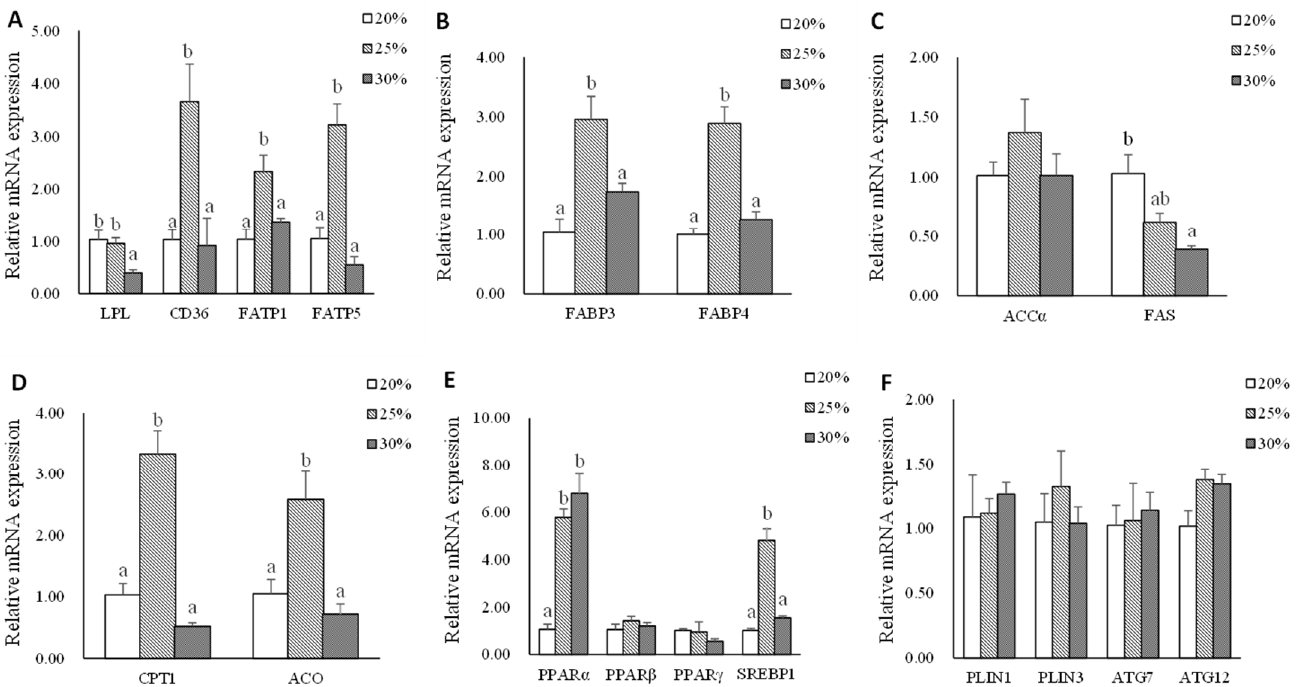
Figure 4. The mRNA expression of genes related to lipid metabolism in muscle of triploid rainbow trout fed with diets containing low (20%), medium (25%), and high (30%) lipid content for 77 days. ( A ) The relative mRNA abundance of lpl , cd36 , fatp1 , and fatp5 shows the ability of lipid uptake. ( B ) The relative mRNA abundance of fabp3 and fabp4 shows the activity of intracellular FA transport. ( C ) The relative mRNA abundance of acc α and fas shows the FA biosynthetic activity de novo. ( D ) The relative mRNA abundance of cpt1 and aco shows the activity of FA β -oxidation. ( E ) The relative mRNA abundance of ppar α , ppar β , ppar γ , and srebp1 in muscle. ( F ) The relative mRNA abundance of plin1 , plin3 , atg7 , and atg12 in muscle. Values are expressed as the means ± S.E.M. (n = 3). Statistical significance was evaluated using one-way ANOVA, followed by Tukey’s test. Values with different letters on columns statistically differ at p < 0.05.